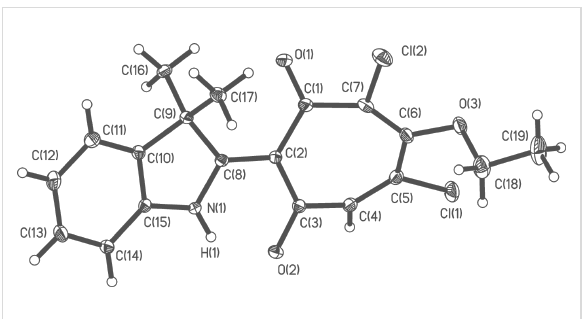
Figure 3: Molecular structure of 2-(3,3-dimethylindolyl)-5,7-dichloro-6- ethoxy-1,3-tropolone 13 . Selected bond lengths (Å): O(1)–C(1)